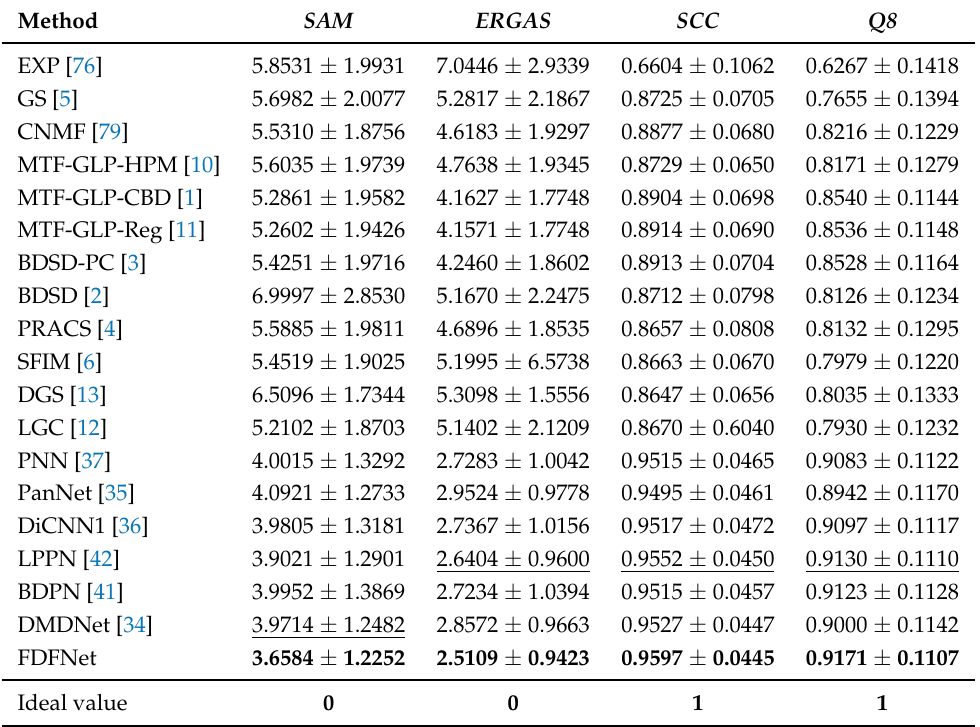
Table 1. Average quantitative with the related standard deviations (std) comparisons on 1258 reduced- resolution WV3 examples. The best performance is shown in bold and second place is